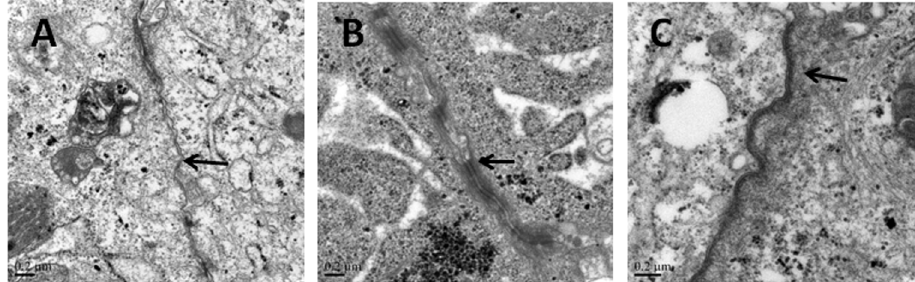
Figure 6. Changes of TJ observed by Transmission Electron Microscopy. Ultrastructure of TJs in a monolayer of cultured IEC-6 cells was observed by a transmission electron microscope. Panel (A) Normal control. (B) LPS–treated cells. The electron-dense materials were diminished in TJ and desmosomes. The space between adjoining cells was widened. (C) CORM-2 attenuated the LPS disruption of TJ and desmosomes. Arrows indicate the location of the TJs (Scale bar=0.2 m m).